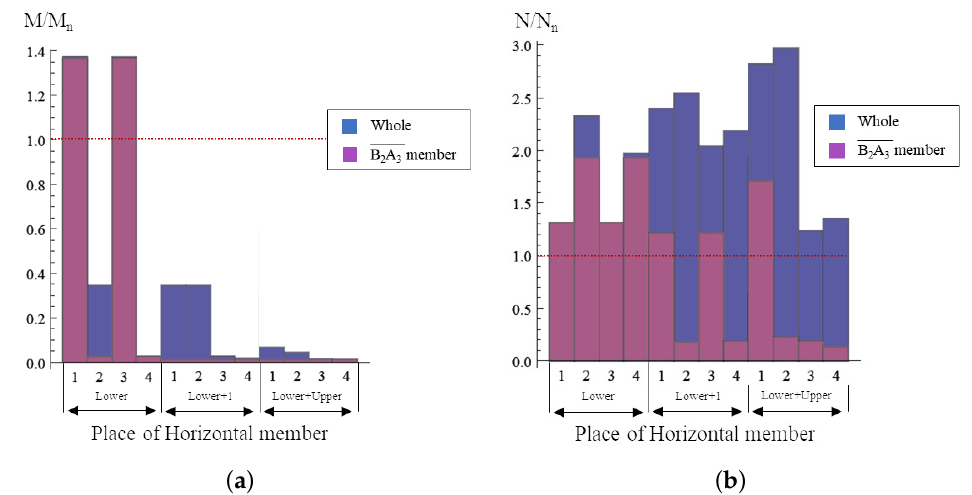
Figure 15. Summarized sectional forces in three units model according to the reinforcing layouts: ( a ) nondimensional bending moment; ( b ) nondimensional axial